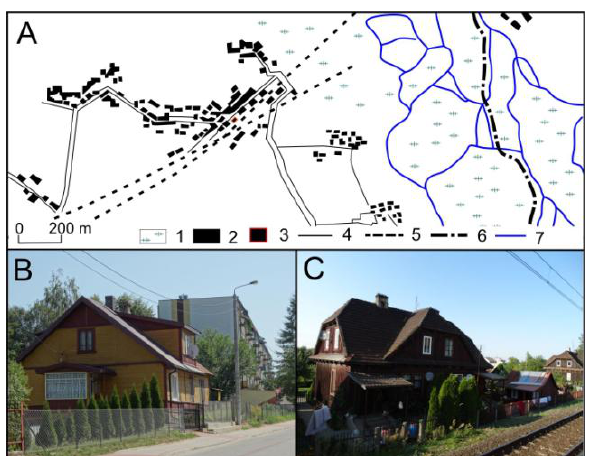
Fig. 4. Spatial layout of Łapy in the beginning of the 20 th century (A), buildings from the 19 th century (B) and buildings the Wigwizdowo colony (C) (Source: author’s own study based on Новая Топографическая Карта…, 1912 (A); photo by author (B-C) 1 – wetlands, 2 – buildings, 3 – railway station, 4 –